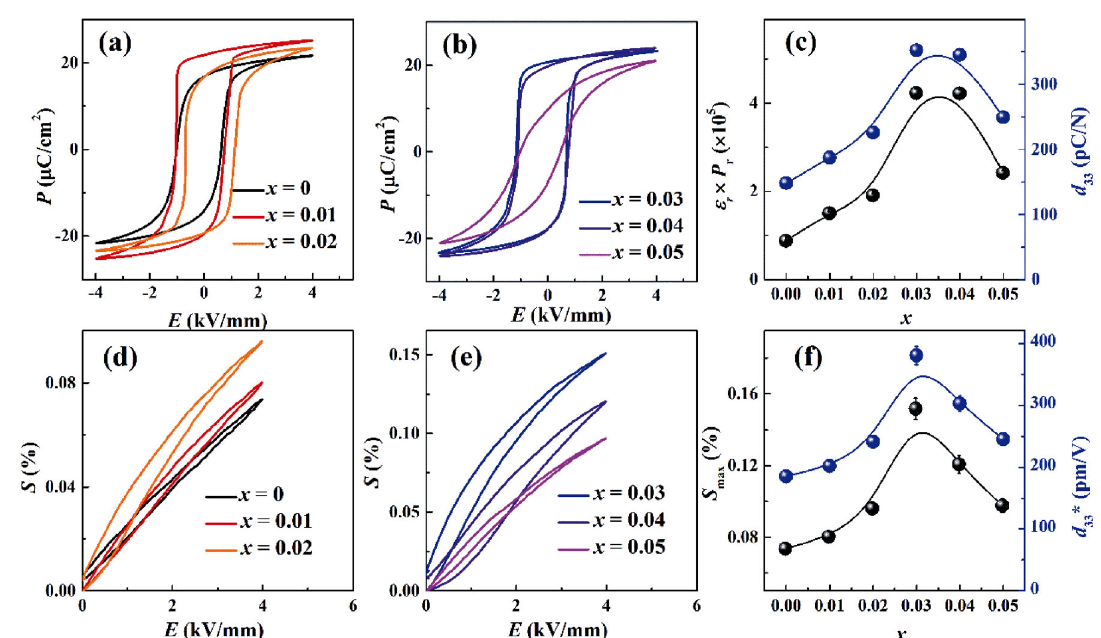
Fig. 8 (a, b) P – E hysteresis loops of (0.99– x )KNNS–CZ– x BNH ceramics. (c) d 33 and ɛ r  P r values as a function of x . (d,